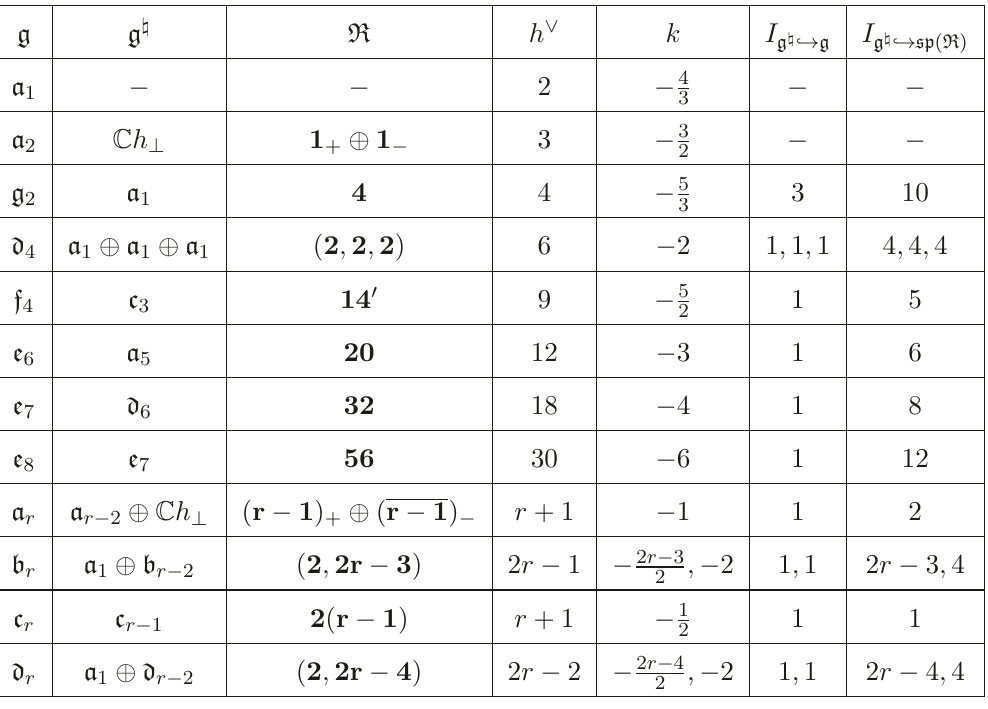
Table 2 . Lie-algebraic data for finite-dimensional simple Lie algebras relevant to the structure of the minimal nilpotent orbit. The top portion of the table corresponds to the Deligne-Cvitanovi´c exceptional series of Lie algebras. The entry for the level is obtained by applying (3.46) (to each simple factor) when g = a 1 , a 2 . See the appendix of [22] for a useful review of embedding 6